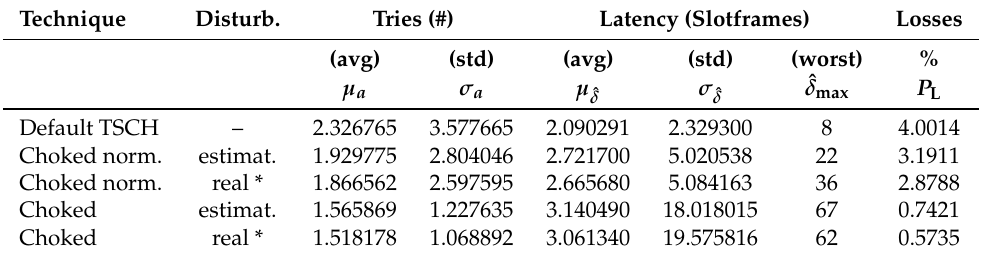
Table 5. Transient analysis (disturbance grows as the time passes).